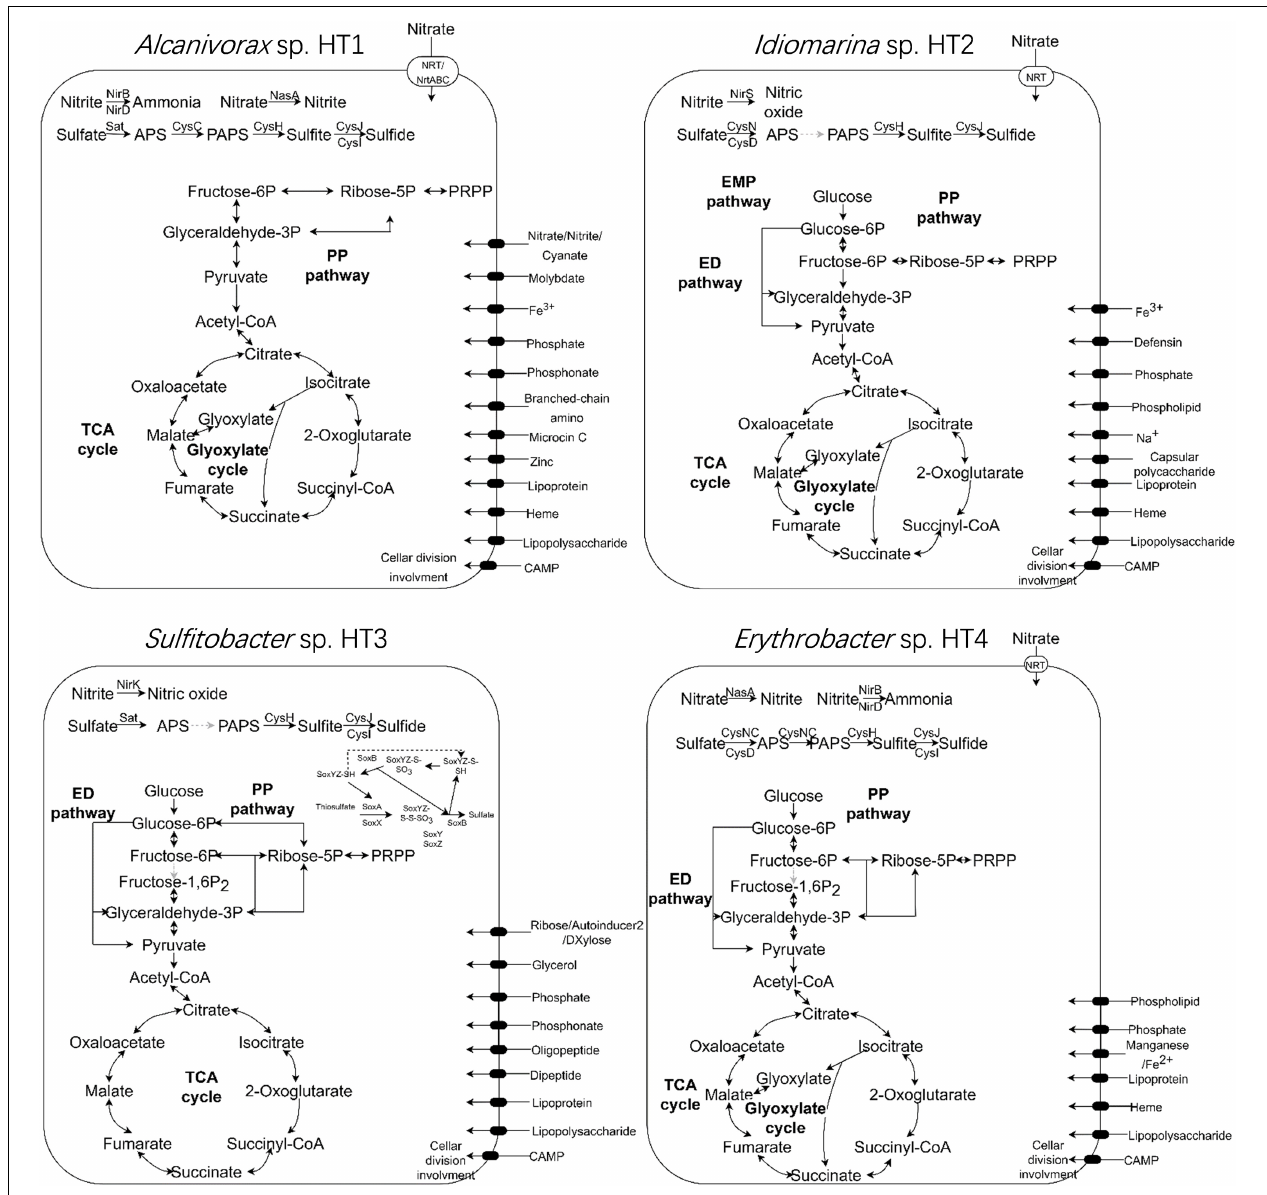
FIGURE 5 | Metabolic pathways in the four genomes ( Alcanivorax sp. HT1, Idiomarina sp. HT2, Sulfitobacter sp. HT3, and Erythrobacter sp. HT4) recovered from the metagenome of the cultured sediment samples. TCA cycle, tricarboxylic acid cycle; PP pathway, pentose phosphate pathway; ED pathway, Entner–Doudoroff pathway; EMP pathway, Embden–Meyerhof–Parnas pathway; PRPP, phosphoribosyl pyrophosphate; PAPS, 3 (cid:48) -phosphoadenosine-5 (cid:48) -phosphosulfate; APS, adenosine-5 (cid:48)